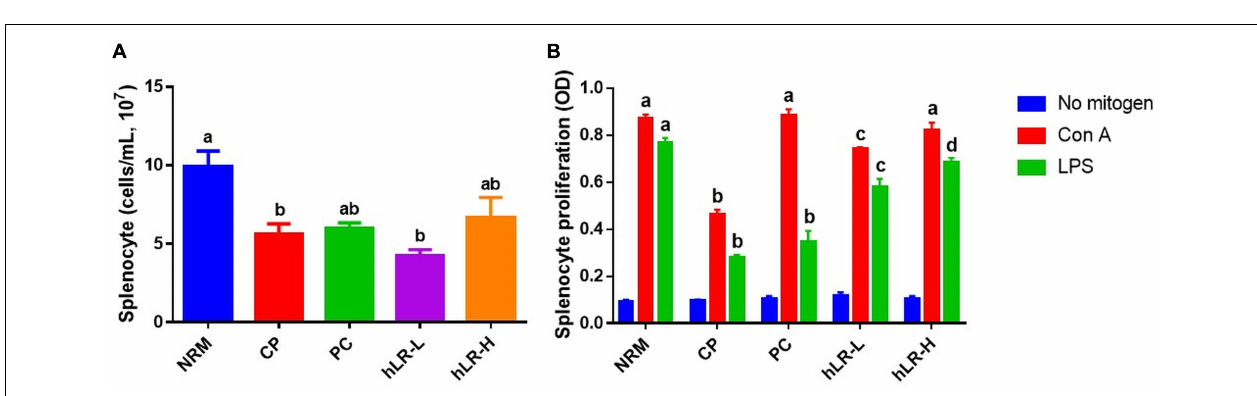
FIGURE 6 | Effects of hLR on splenocyte proliferation. (A) Splenocyte counts in different groups. (B) Con A- and LPS-induced splenocyte proliferation. Data are the mean ± SEM ( n = 4). Different letters above the bars indicate a significant difference between the groups ( p < 0.05).